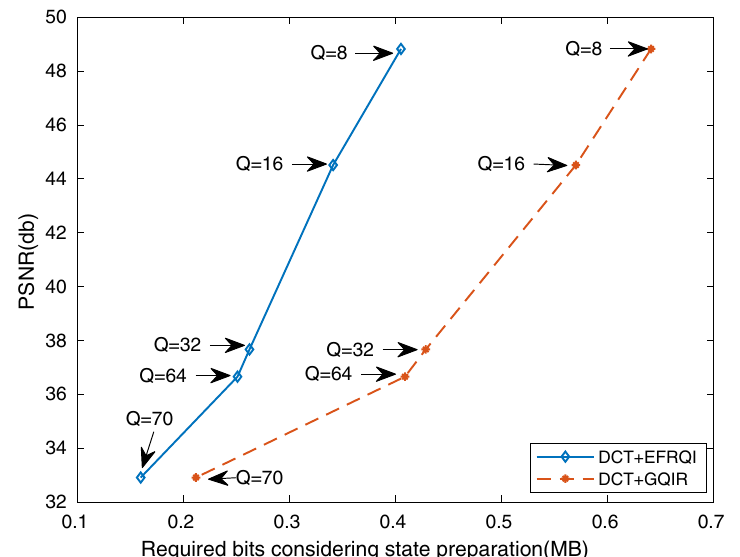
Figure 7. Required bits (MB) versus PSNR (db) for cameraman image.